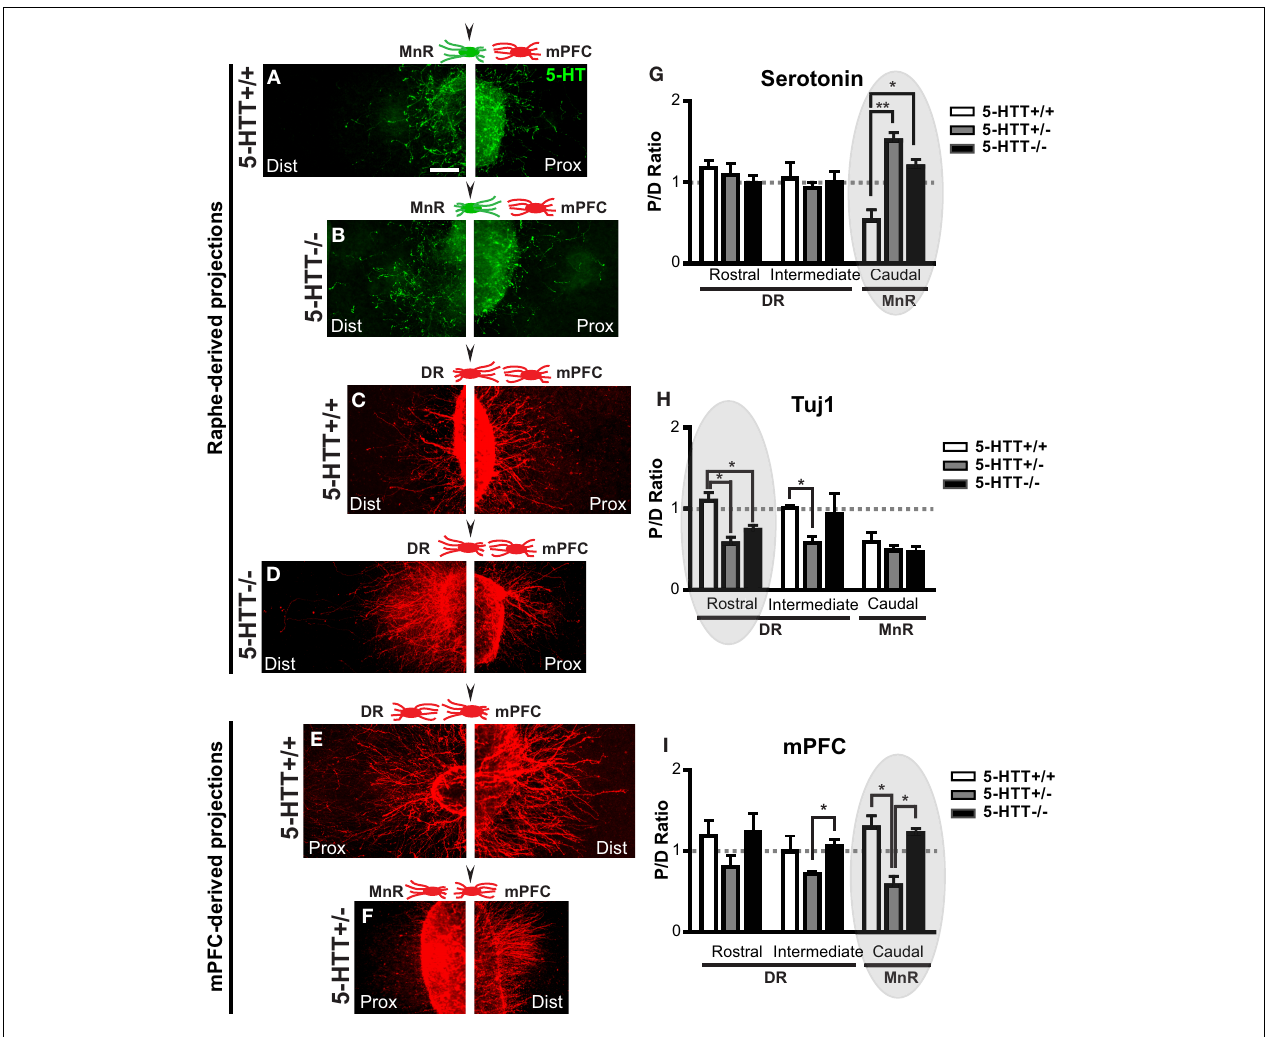
FIGURE 2 | The chemotrophic nature of the interaction between the mPFC and the DR and MnR depends on 5-HTT during development. (A-F) High magnification photographs of proximal and distal quadrants of the raphe (positive for 5-HT, green and Tuj1, red) and the mPFC (Tuj1, red). Arrowhead in schematic representations indicate the example given. (G,H) Quantification of the length of 5-HT-positive and Tuj1-positive neurites in the proximal and distal quadrants of the DR and the MnR, co-cultured with